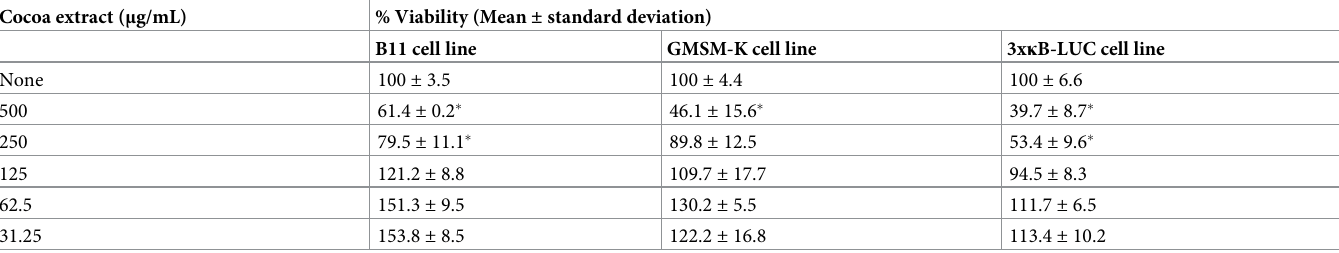
Cell viability following a 24-h treatment was assessed using an MTT (3-[4,5-diethylthiazol-2-yl]-2,5diphenyltetrazolium bromide) colorimetric assay. � , Significant decrease ( p < 0.01) in cell viability compared to untreated control